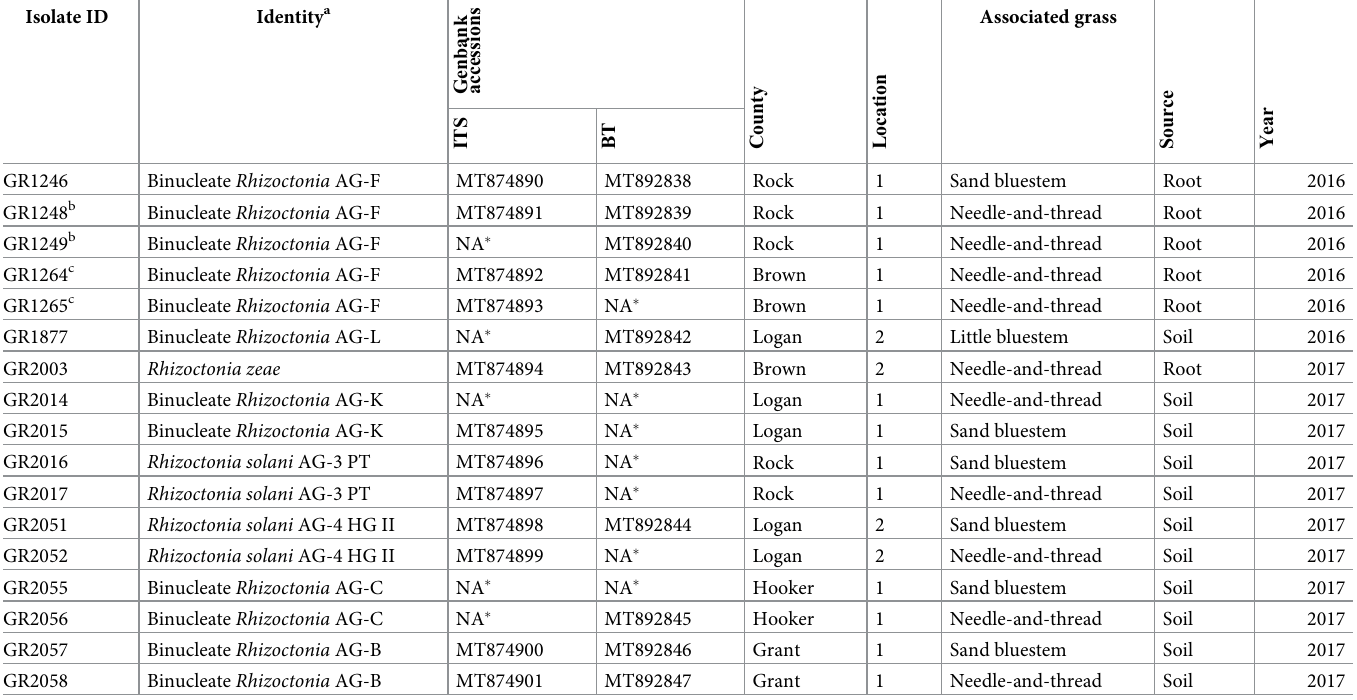
Table 1. List of Rhizoctonia spp. isolated from seven non-cultivated sites in the Sandhills. Isolate ID Identity a